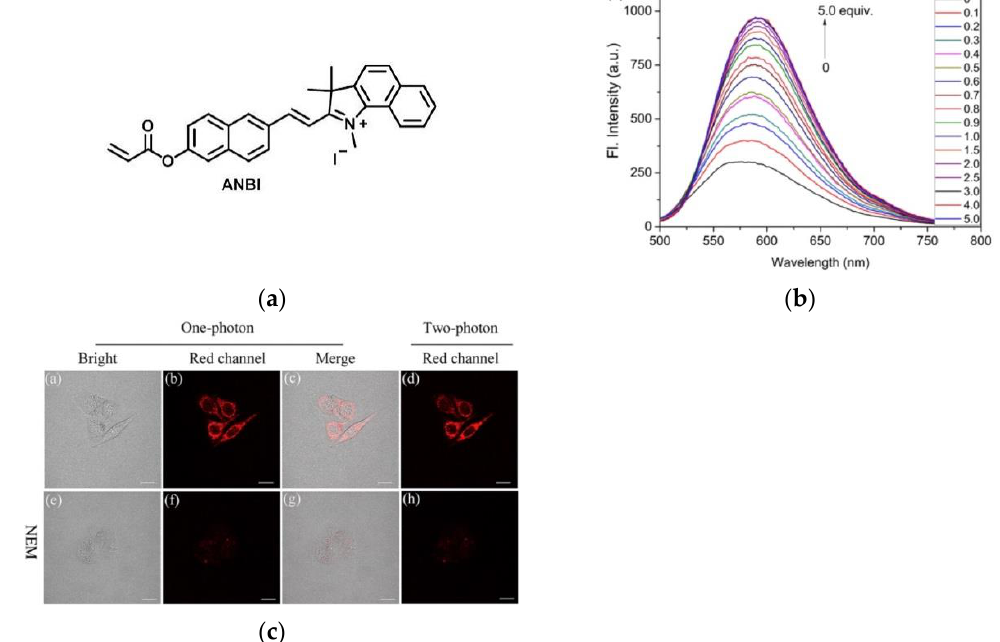
Figure 23. ( a ) The structure of probe ANBI; ( b ) Fluorescence spectra of ANBI with Cys; ( c ) Fluo- rescence images of HeLa cells. Reproduced with permission from [104]. Copyright 2017 Elsevier Ltd.